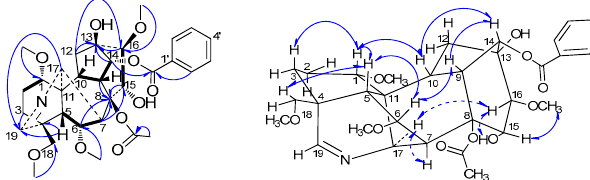
Figure 2. Key 1 H- 1 H COSY (H H), HMBC (H → C) and ROESY (H ↔ H) correlations of compound 1 . Table 1. 1 H-NMR and 13 C-NMR spectral data of compounds 1 – 5 .